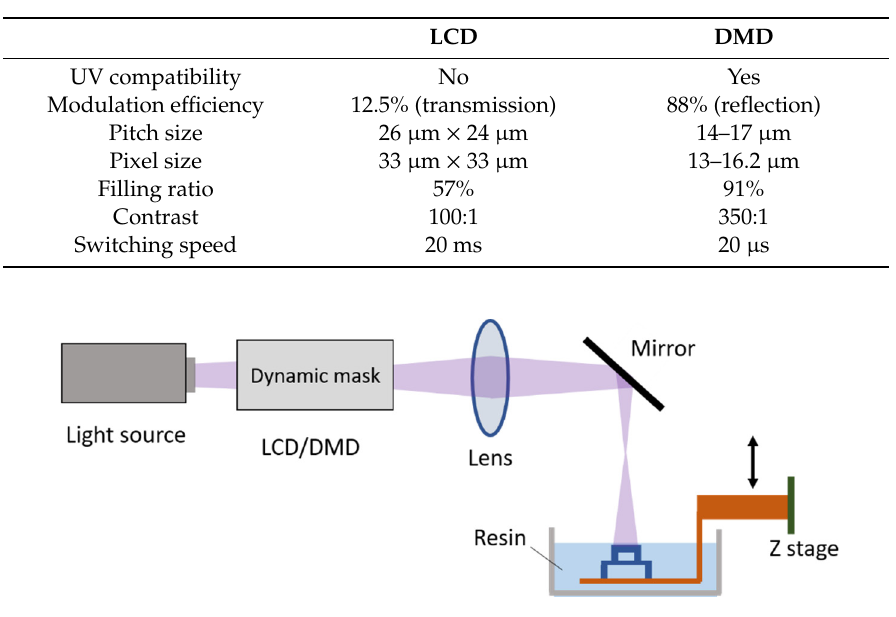
Figure 5. The top-down projection stereolithography system.